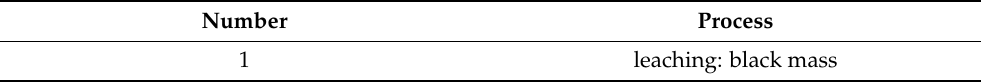
Table A18. Activities of the main application process “recycling”: recovery of